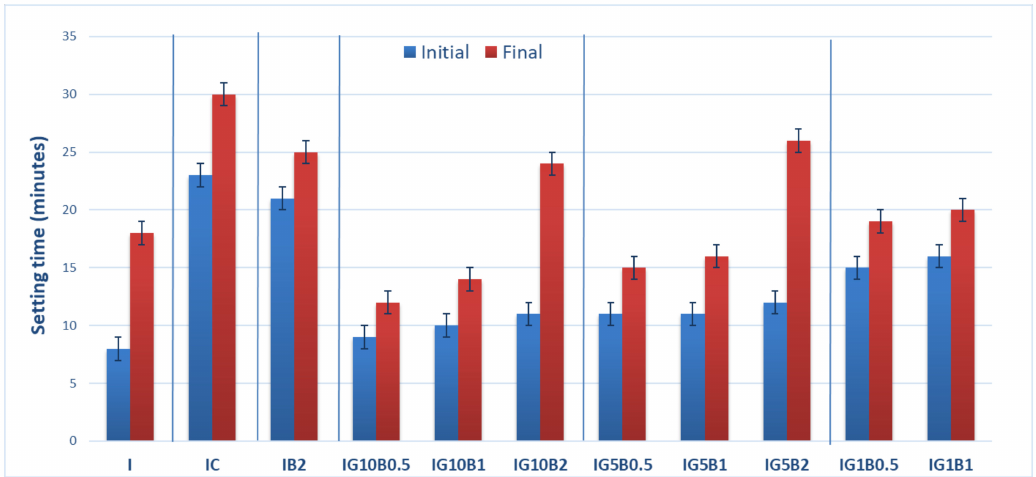
Figure 2. Setting times of gypsum binders with 0.3% HEMC (IC) and various amounts of sodium bicarbonate (0.5%, 1% and 2%) and FGD gypsum (1%, 5% and